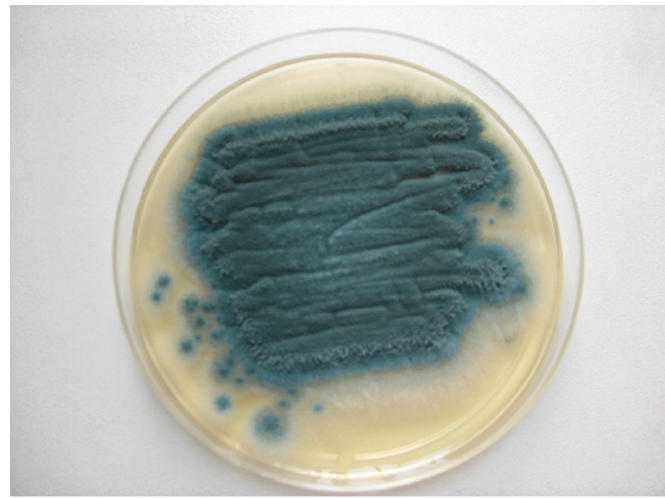
Figure 4. Culture of Aspergillus fumigatus on Sabouraud chloramphenicol gentamicin agar (Bio-Rad, Marnes-la-Coquette, France).